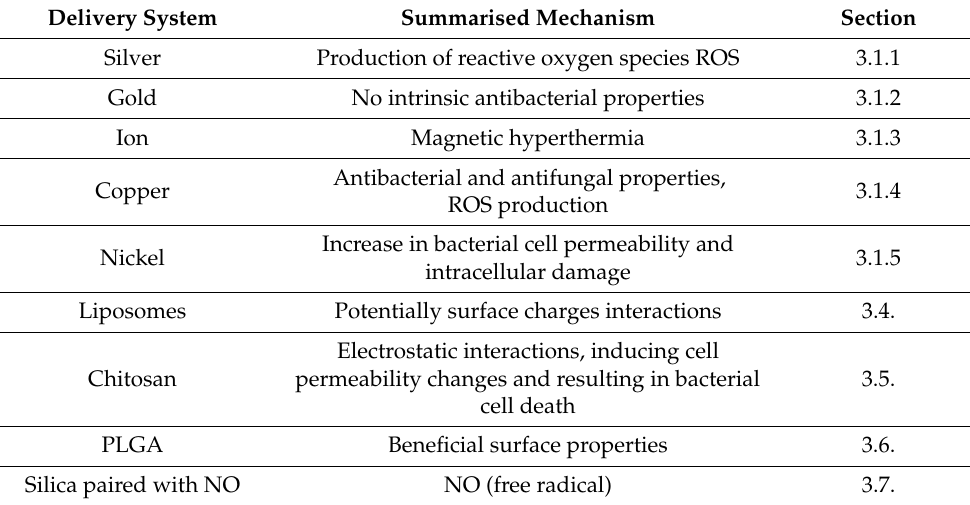
Table 2. Summary of the potential mode of